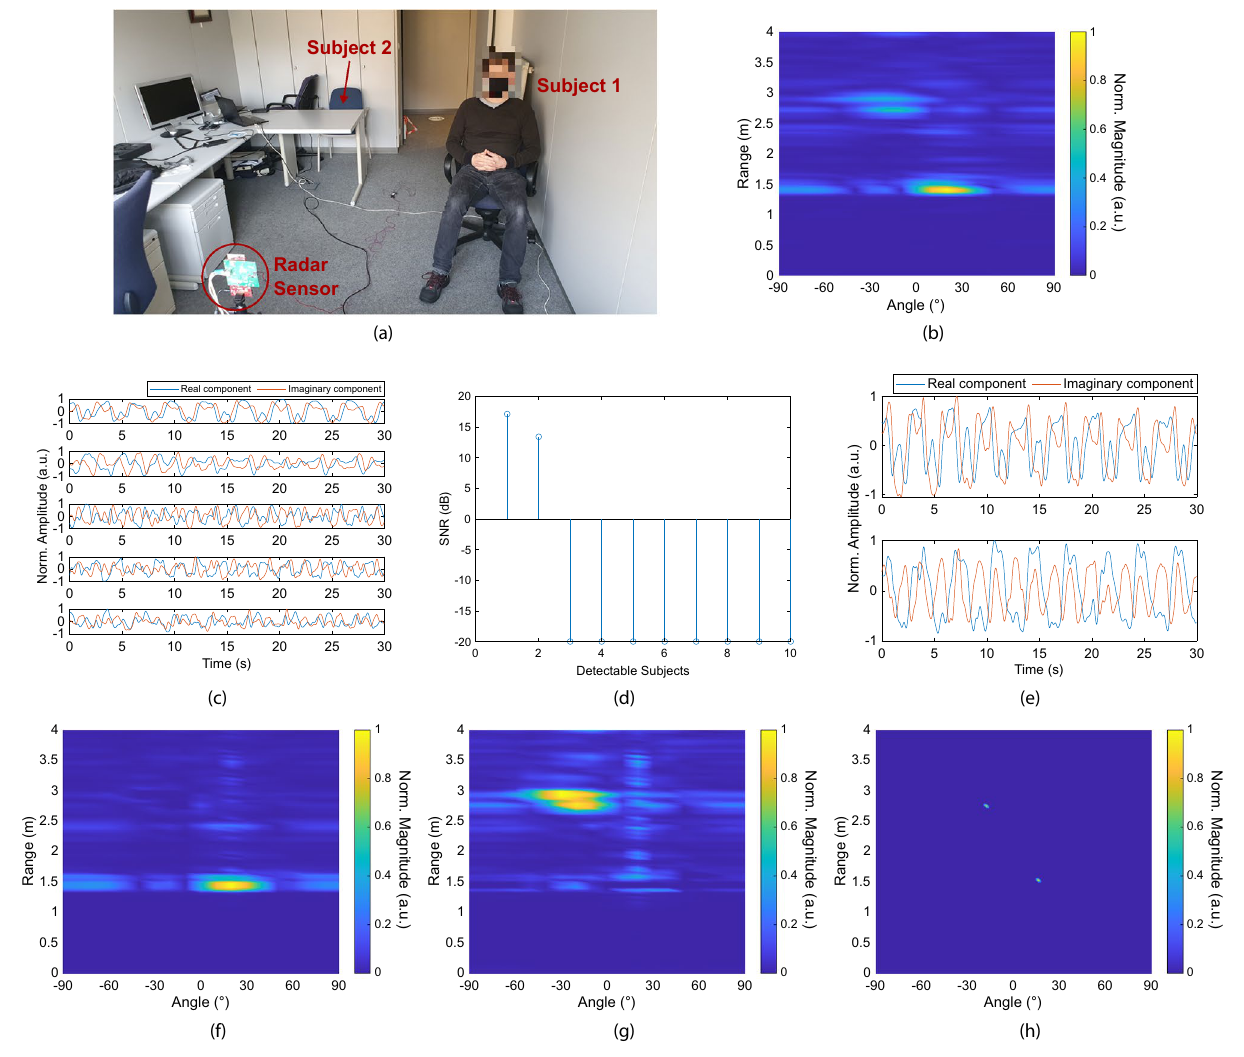
◦ ◦ and 2.7 m / -18.71 ◦ ◦ was used for ( b ), ( f ), ( g ) and one of 2